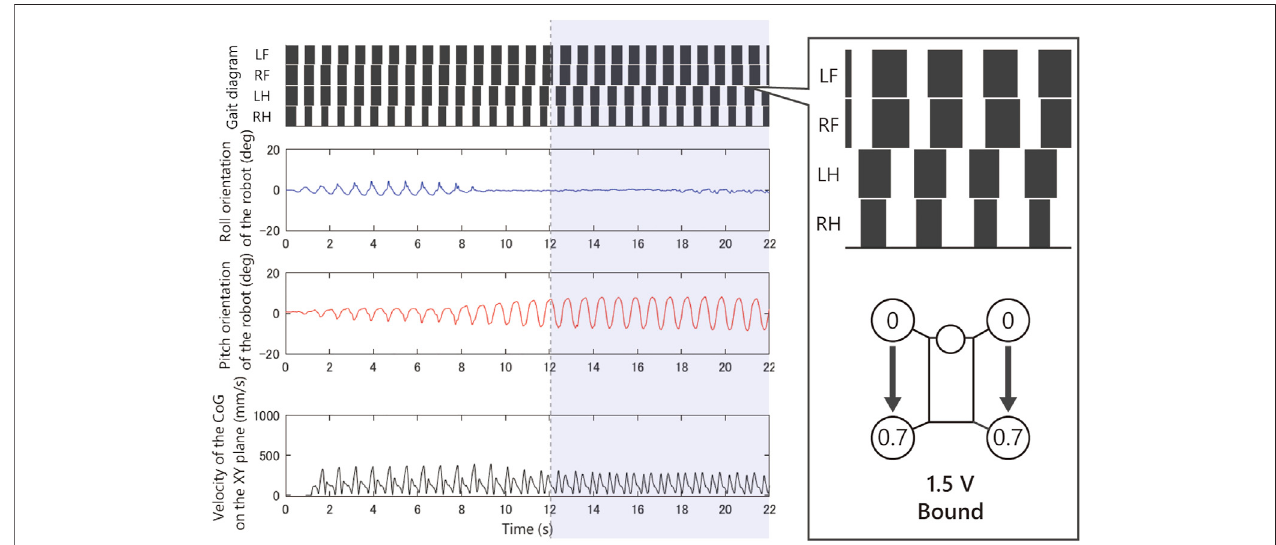
FIGURE 9 | Experimental result with an input voltage of 1.5 V. From the top: gait of the quadruped robot, roll, and pitch orientation. This bound gait emerged from only a few initial values.